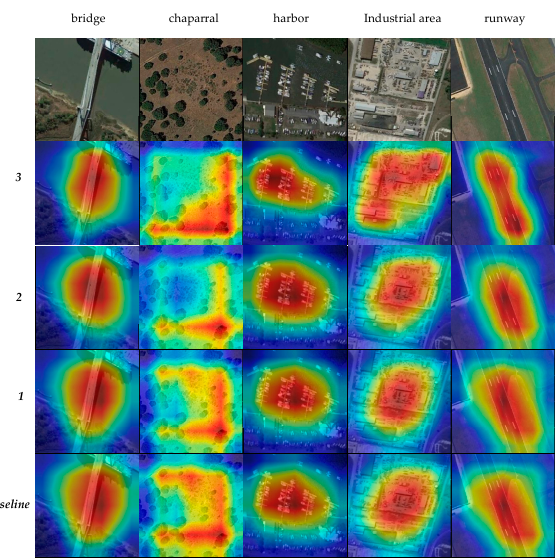
Figure 11. The attention maps of baseline , 1 , 2 , and 3 . The categories displayed are bridge, chaparral, harbor, industrial area, and runway.